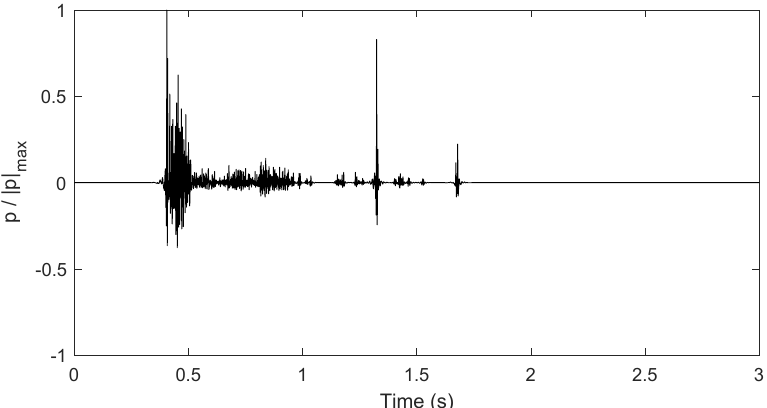
Figure 16. Impulse response at the receiver with a 24 m long, 5.5 m high straight barrier placed 2.1 m far from the transformers.